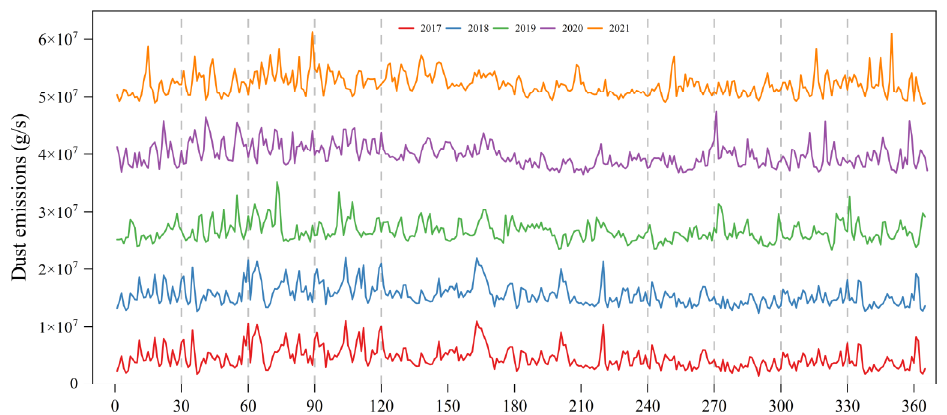
Figure 3. Global daily dust emissions from agricultural land, 2017–2021. Note: 1–365 or 366 for January 1st to December 31st of each year.